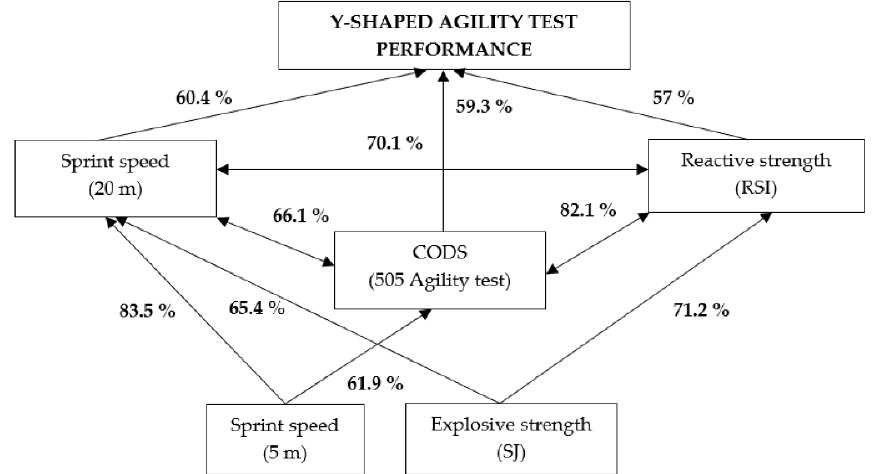
Figure 1. Percentual contributions of factors determining Y-shaped agility test performance based on the coefficients of determination for the tests described in this work for handball players.